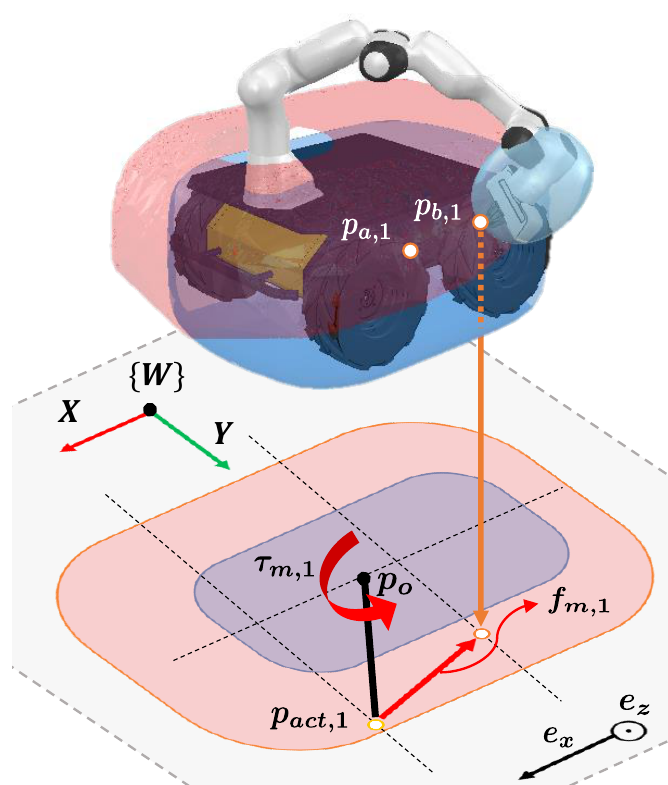
Figure 9. Illustration of generating the desired force and resulting torque for the link pair L m ( 1 ) . When the end-effector and mobile robot are close to each other, the force f m ,1 and resulting torque τ m ,1 with respect to the center of the mobile robot, p o , are generated. The generated force and resulting torque are projected onto the acceleration directions of the mobile robot under the non-holonomic constraint. The directions are expressed as the unit vectors, e x and e z